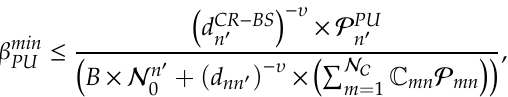
Table 2. List of acronyms.